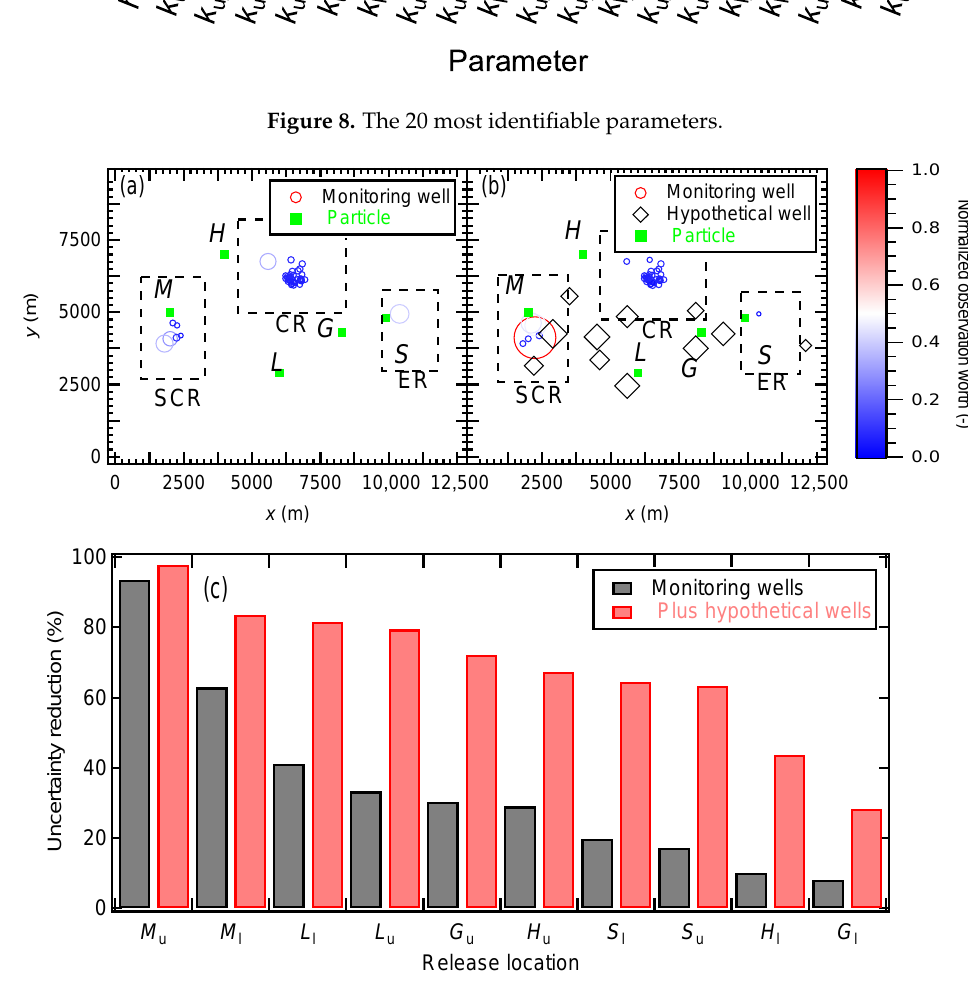
Figure 9. Normalized observation worth of ( a ) monitoring wells ( b ) plus 11 hypothetical wells, symbol color and size indicate the observation worth; and ( c ) uncertainty reductions in travel times due to the existing wells (gray) and as augmented by 11 hypothetical wells (red). Subscripts u and l represents upper and lower layers,